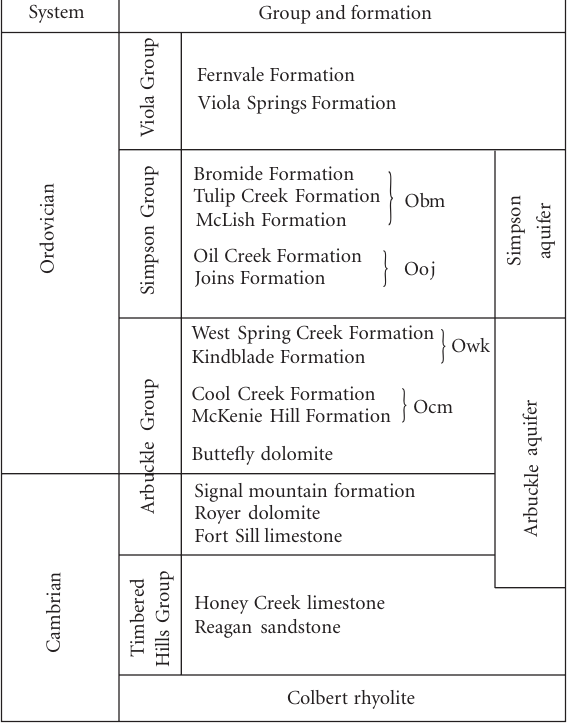
Figure 2: Stratigraphic nomenclature for the pre-Sylvan Ordovician and Cambrian rocks that outcrop in the Arbuckle Mountains. Positions of the Arbuckle and Simpson aquifers are shown on the stratigraphic column (after